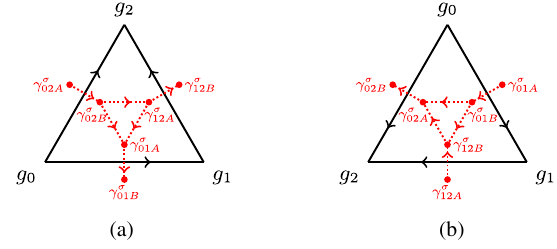
FIG. 2. Kasteleyn orientations of the resolved dual lattice. For a given triangulation of the 2D spatial spin manifold (shown by black links), we can construct a resolved dual lattice (shown by red links). The Majorana fermion pairings should respect the red link arrows in the